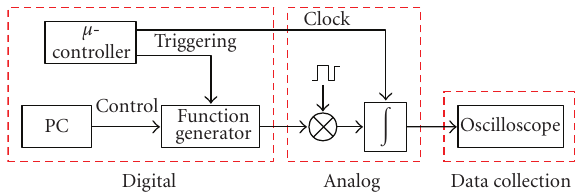
Figure 9: Overall configuration of the prototype using o ff -the-shelf components.